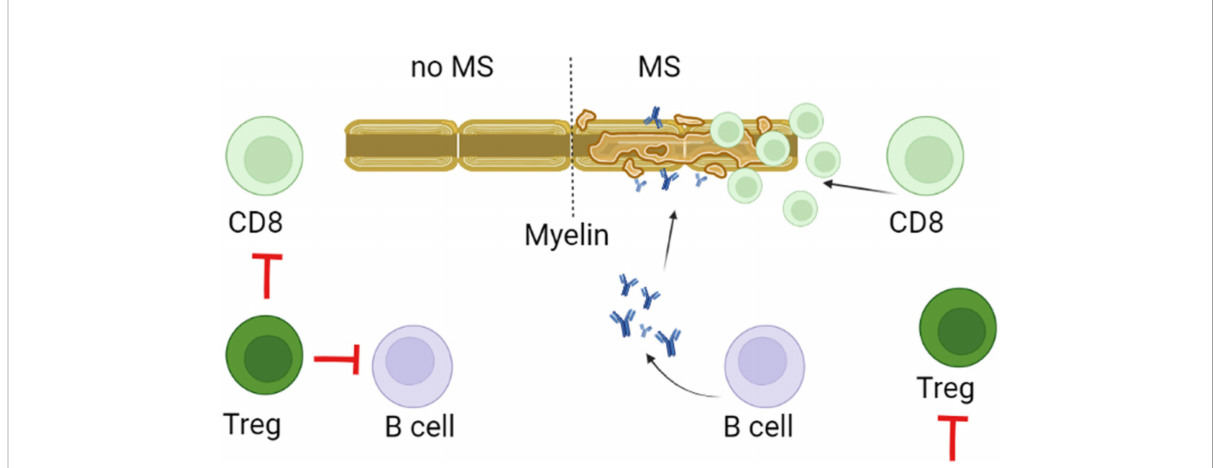
FIGURE 3 Role of Tregs in pathogenesis of MS. Tregs control of the immune homeostasis focused on preventing differentiation, proliferation and survival of autoreactive myelin targeting CD8+, Th17 and B cells. This control depends on the direct contact as well as the release of IL-10 and TGF- b by Tregs. It is believed that in MS, decreased activity and lower counts could reduce the regulatory capacity of Tregs. This could promote survival, proliferation and differentiation of myelin reactive CD8, Th17 and B